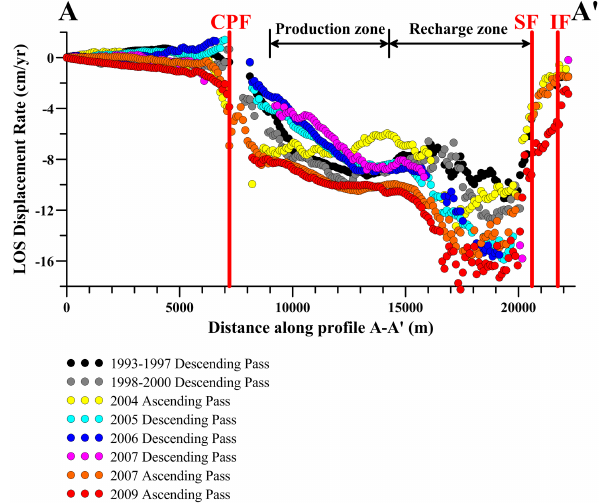
Figure 3. Comparison between LOS displacement rates derived from multiple Differential Interferograms Stacking (DIS) proce- dure for different periods along the profile A-A’ (location shown in Fig. 1). Solid red lines indicate location of tectonic faults which cross the profile. Faults notation as in Fig.